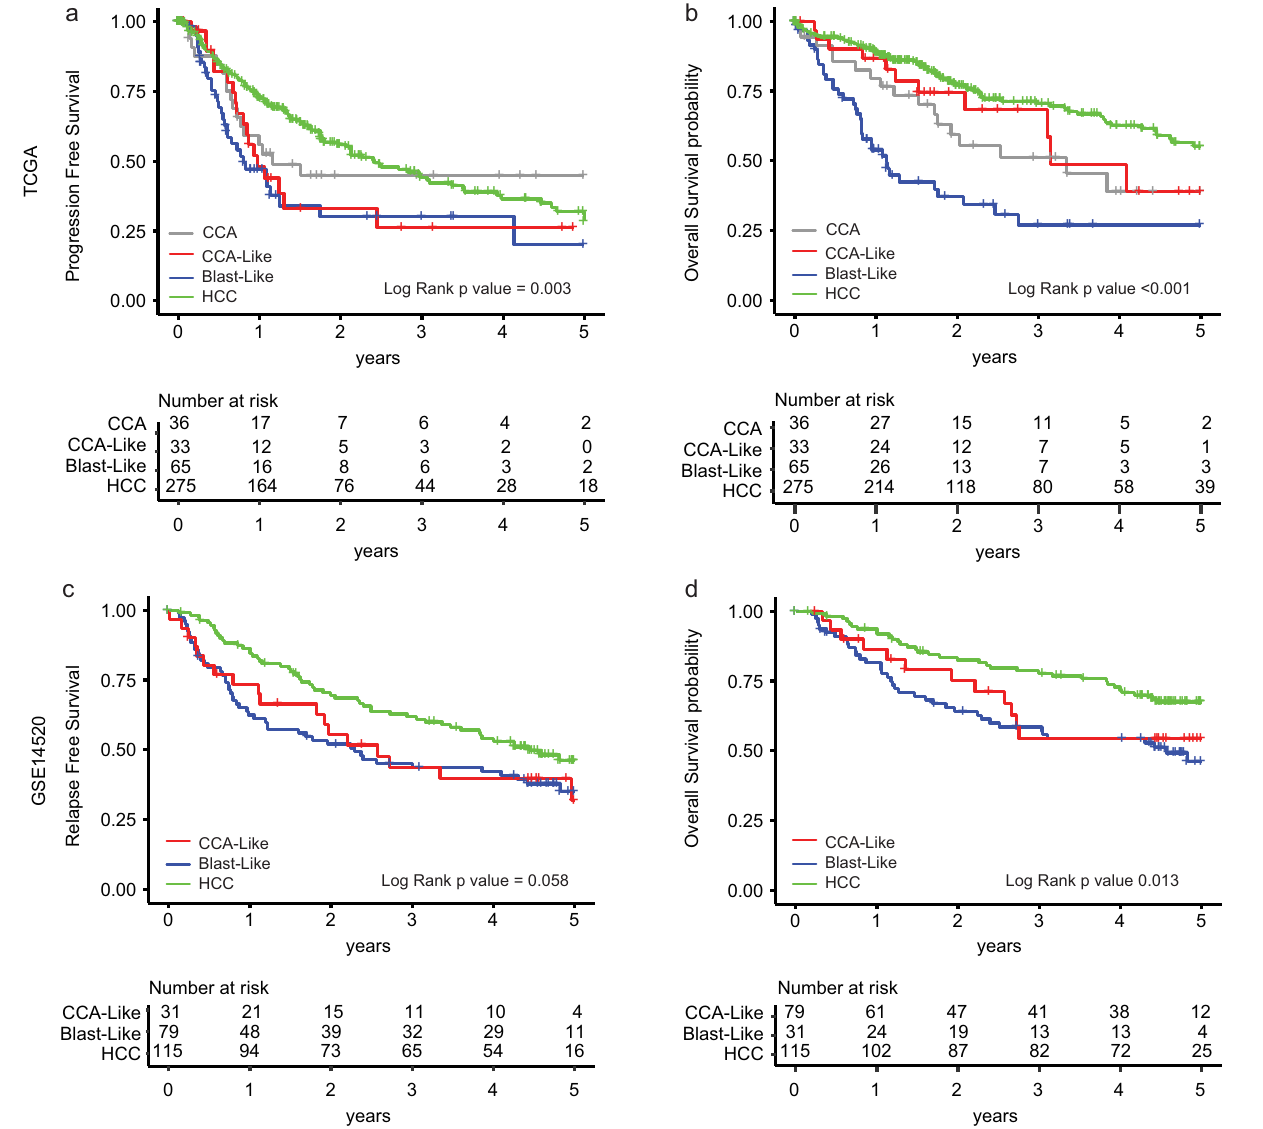
Fig. 6 Blast-Like tumor have worse progression-free and overall survival. Kaplan − Meier curves of TCGA CCA/HCC data for a progression-free and b overall survival. Tumor classi fi cations were predicted on to GSE14520 using ClaNC for c relapse-free and d overall survival 32 . All survival data was censored at 5 year and log-rank p value was